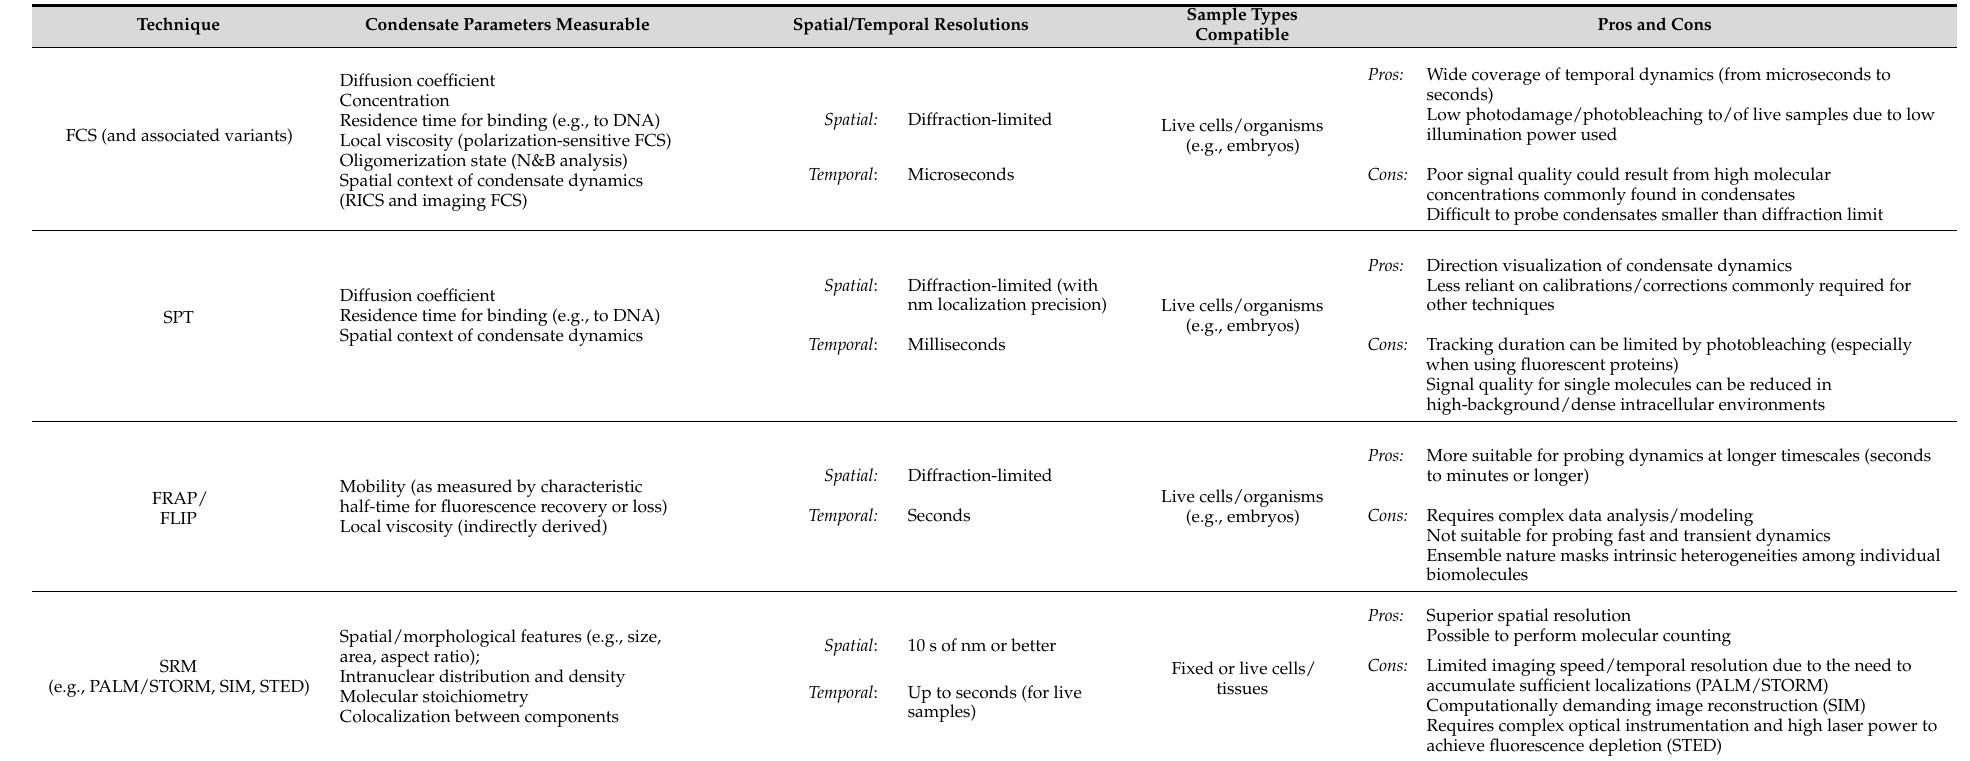
Table 1. Commonly used quantitative imaging techniques for the characterization of chromatin-based phase condensates and their respective capabilities, advantages and